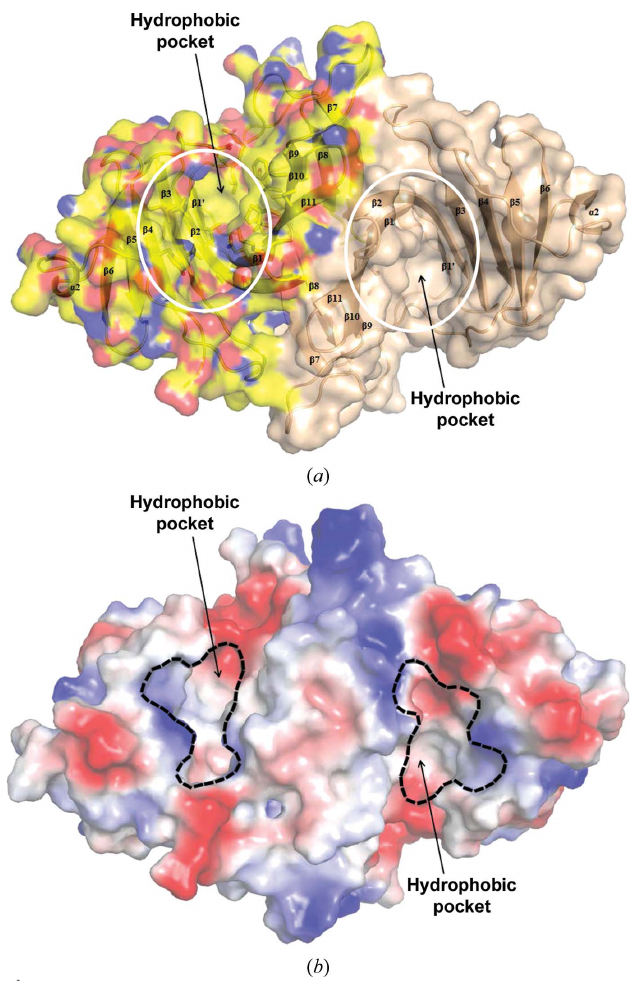
Figure 4 Surface colored by atom type ( a ) and charge-smoothened vacuum contact electrostatic surface ( b ) of human EPDR1. ( a ) The surface rendering (N atoms in blue, O atoms in red and C atoms in yellow) of dimeric human EPDR1 shows a deep hydrophobic cleft. The approximate regions of the hydrophobic pockets are circled in white. ( b ) The surface of negative and positive electrostatic potential patches generated using a charge- smoothened contact potential in PyMOL more clearly illustrates the hydrophobic pocket located within each of the monomeric subunits in the EPDR1 dimer. [Note that the negative (red) and positive (blue) charges scaled in K B T /e c units at pH 7 ( K B , Boltzmann constant; e c , charge on the electron) are only qualitatively useful]. The boundaries of the hydro- phobic pocket entrances are indicated in